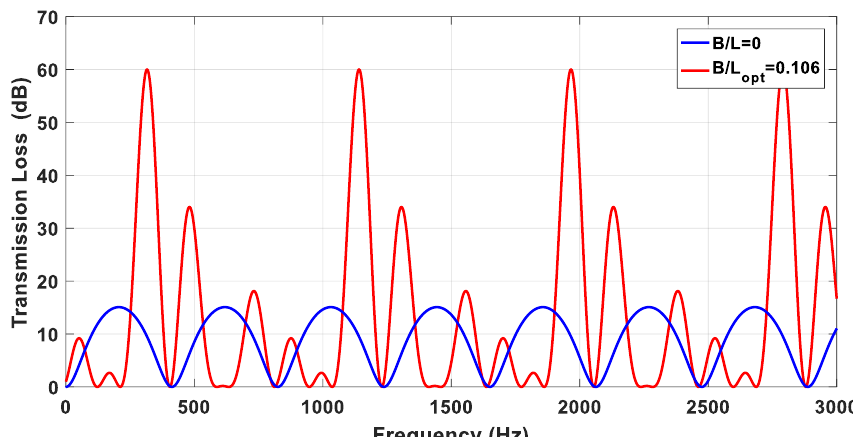
Figure 19. TL of DCLCM with optimal value of S/C ratio (B/L), compared with the system without muffler 𝐵/𝐿 = 0 .